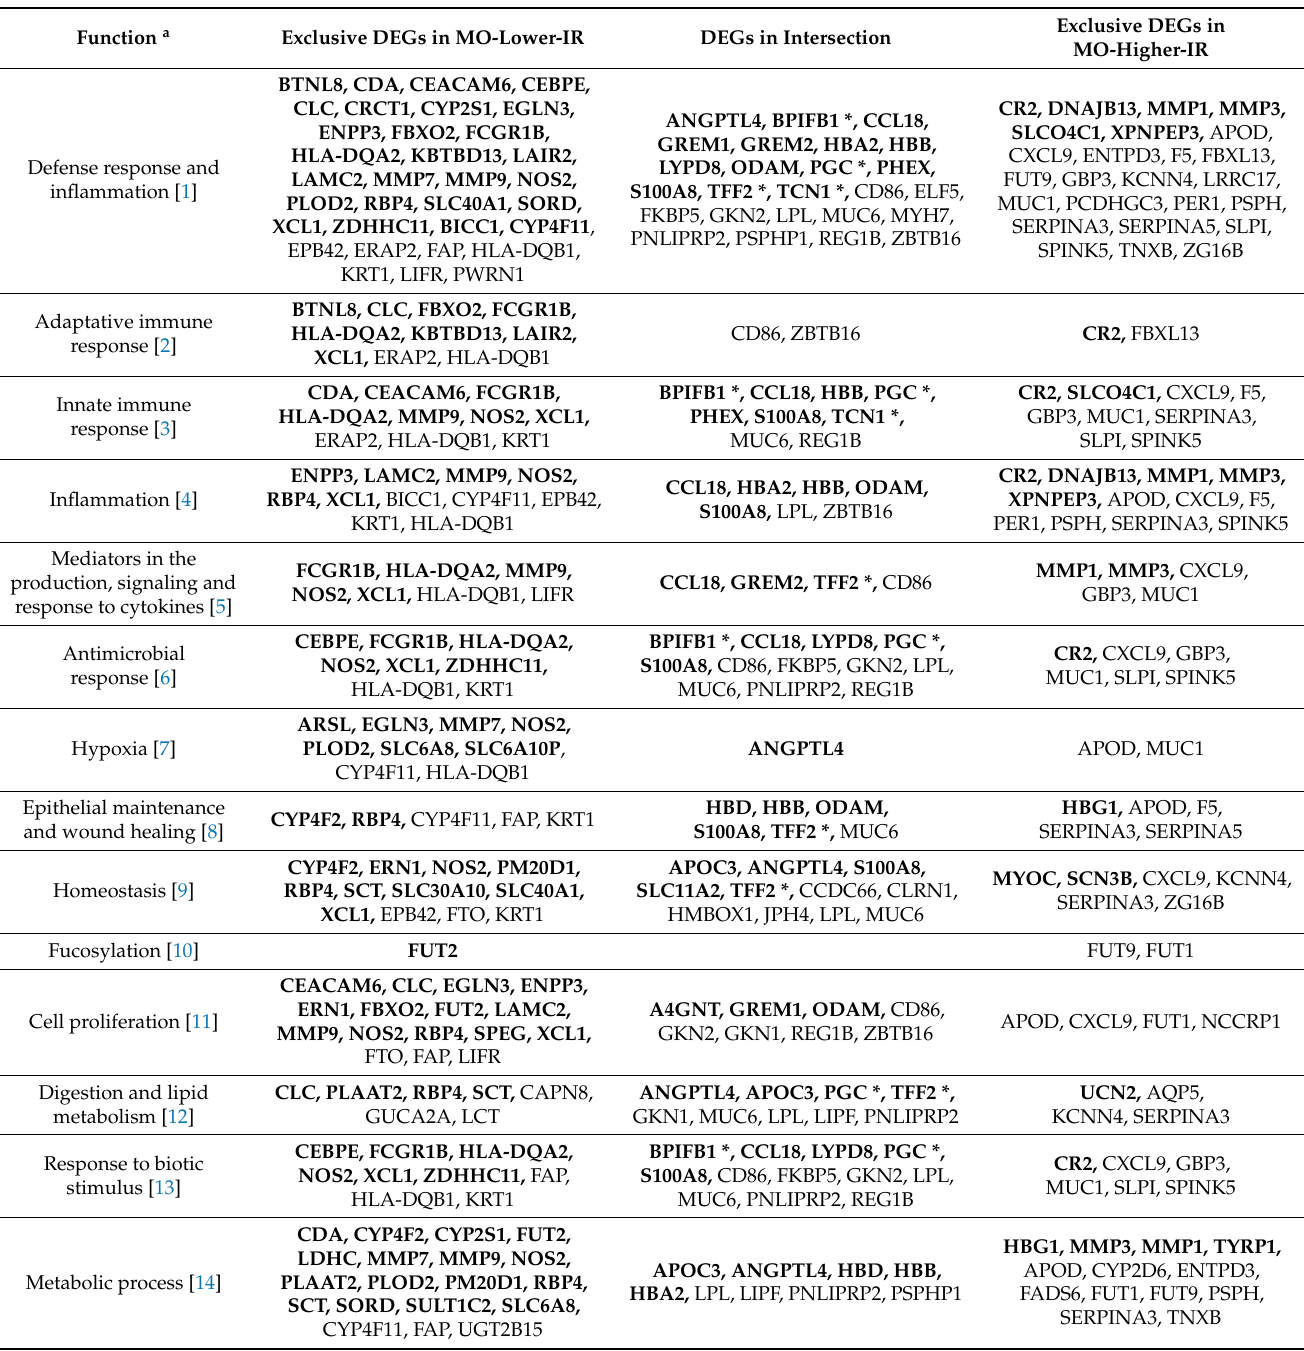
Table 2. Significantly overrepresented (FDR < 0.05) gene sets involved in different functions obtained from the analysis of differentially expressed genes (DEGs) found in the intersection, from exclusive DEGs found in MO-low-IR and from exclusive DEGs found in